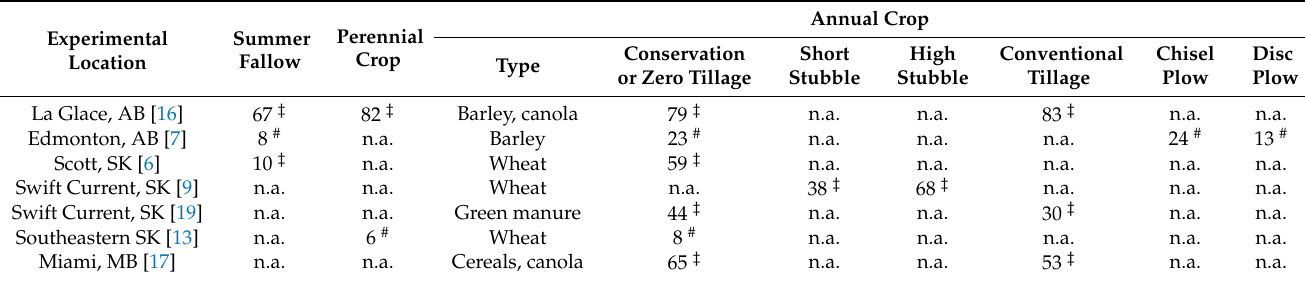
Table 2. Snow trapping (snow water equivalent, mm) as affected by different types of crops and crop residue management practices.